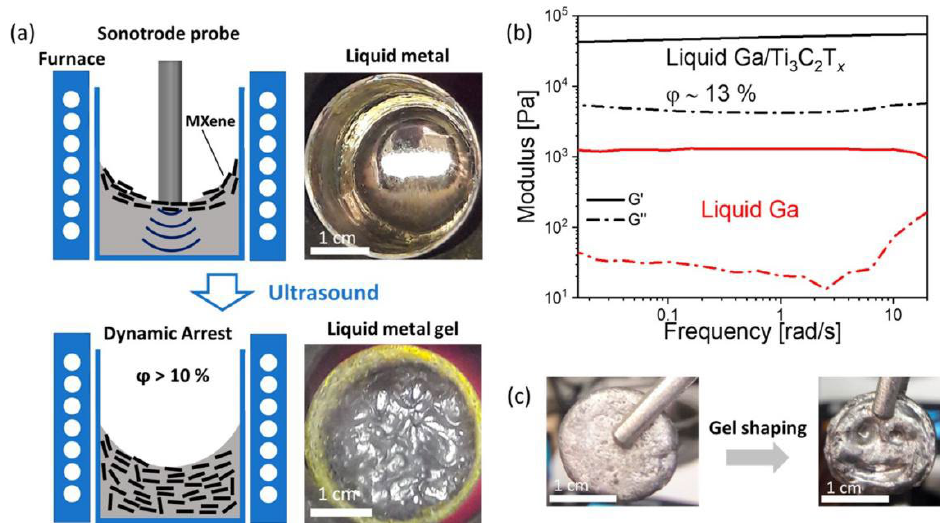
Figure 23. ( a ) Schematic for the preparation of Ti 3 C 2 T x MXene dispersions in lightweight metals and photographs of the crucibles. ( b ) Real (G) components of the complex modulus describing viscoelastic properties of liquid Ga with and without Ti 3 C 2 T x MXene flakes. ( c ) Demonstration of shaping the gelated composite of Ti 3 C 2 T x Mxene in Al-Mg alloy above the alloy melting temperature of 432 °C. Reprinted with permission from [73]. Copyright 2019 American Chemical Society.